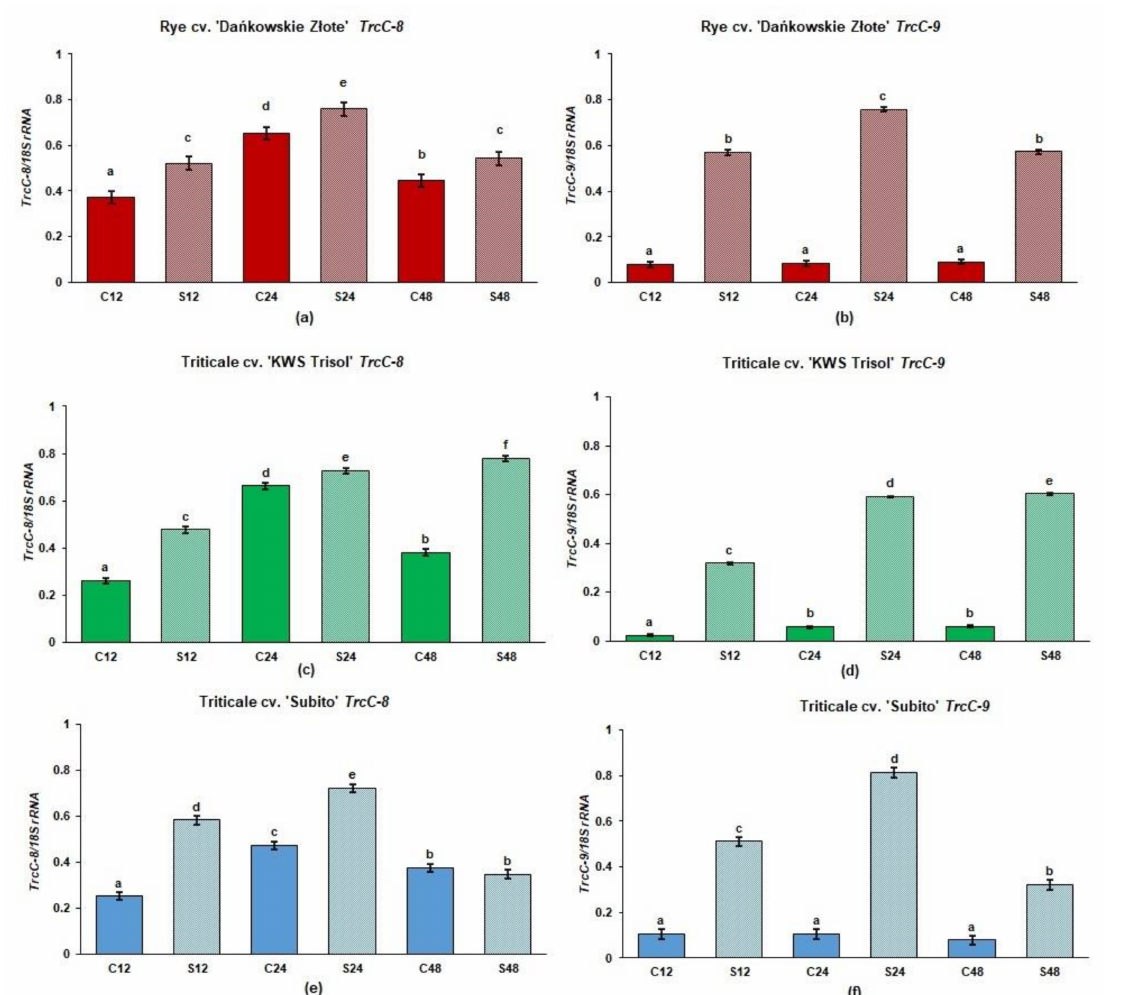
Figure 2. The gene expression of phytocystatins in roots of tolerant rye cv. “Da´nkowskie Złote”, tolerant triticale cv. “KWS Trisol” and sensitive triticale cv. “Subito” at 12, 24 and 48 h after treatment with Al 3+ (0.59 mM) (S) and in untreated plants (C). ( a ) “Da´nkowskie Złote” TrcC-8 ; ( b ) “Da´nkowskie Złote” TrcC-9 ; ( c ) “KWS Trisol” TrcC-8 ; ( d ) “KWS Trisol” TrcC-9 ; ( e ) “Subito” TrcC-8 ; ( f ) “Subito” TrcC-9 . Figure shows relative expression (ratios of TrcC-8 and 9 to 18S rRNA ) of phytocystatin genes after densitometric analysis of the bands. Results are shown as means ± confidence intervals. Different letters indicate significant differences among values after one-way analysis of variance and Tukey’s honestly significant difference procedure at p <